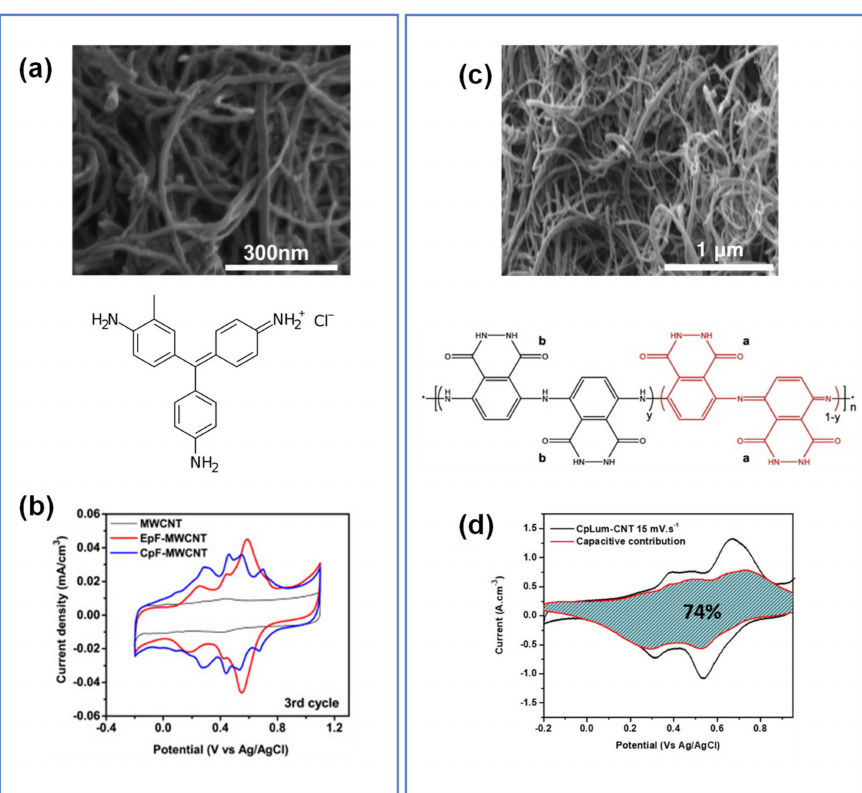
Figure 14. ( a , b ) SEM, CV profile of CpF-CNT (100 mV/s) and EpF-CNT, ( c , d ) SEM micrograph and CV profile showing the capacitive contribution in CpLum-CNT composite (15 mV/s). All CVs were obtained in 1 M H 2 SO 4 electrolyte. Reproduced with permission from Refs.